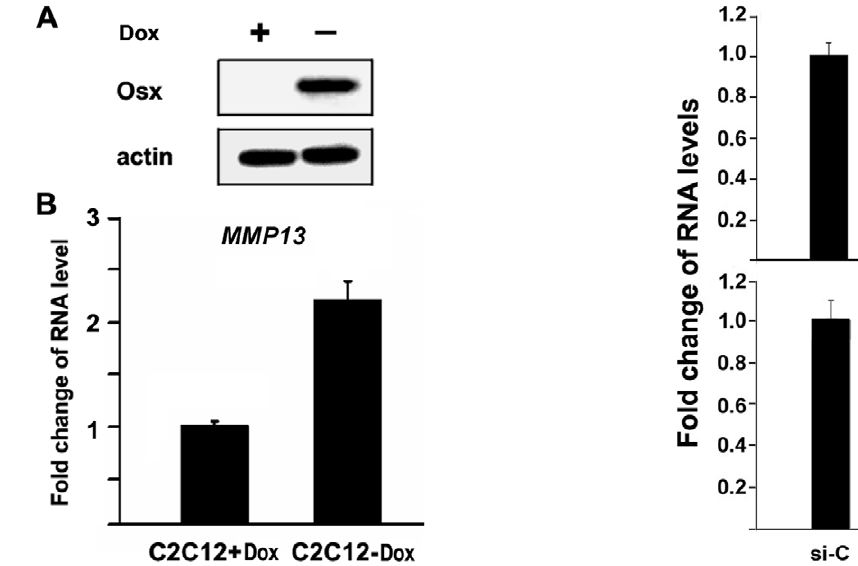
Figure 2. Overexpression of Osx activates MMP13 gene expression in C2C12 mesenchymal cells. (A) Western immunoblot analysis of the Dox-regulated Osx-expressing C2C12 cells. Osx expression is turned on in the absence of Dox. Beta-actin was used as a loading control. (B) MMP13 mRNA levels in a stable Tet-off C2C12 mesenchymal cell line. RNA was obtained from cultures treated with or without Doxycycline. Osx expression is induced in the absence of Doxycycline in this stable cell line. MMP13 mRNA levels were quantitated by real-time RT-PCR. The MMP13 RNA level obtained from the cells cultured with Dox was normalized to a value of 1. Values are presented as the mean 6 S.D.